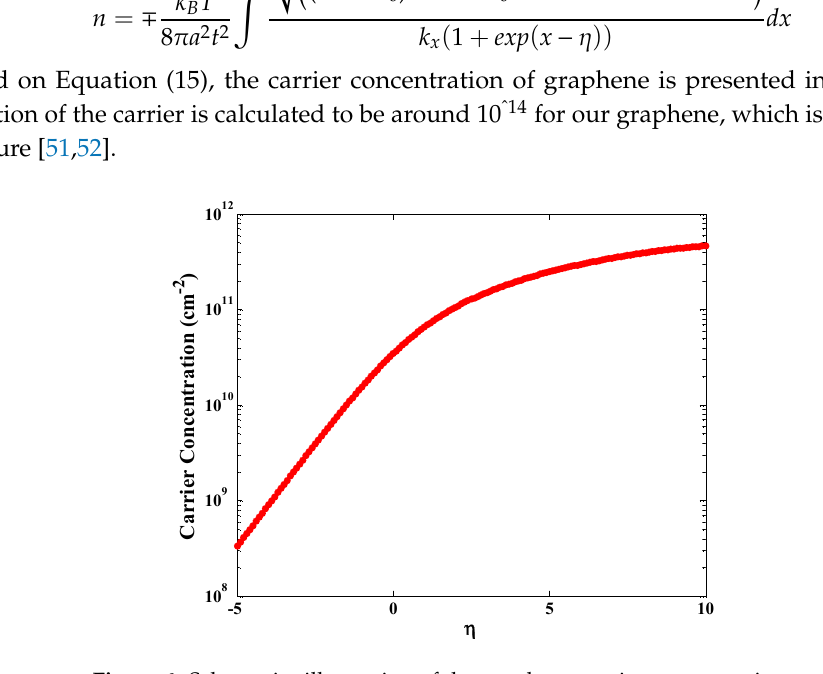
Figure 6. Schematics illustration of the graphene carrier concentration.